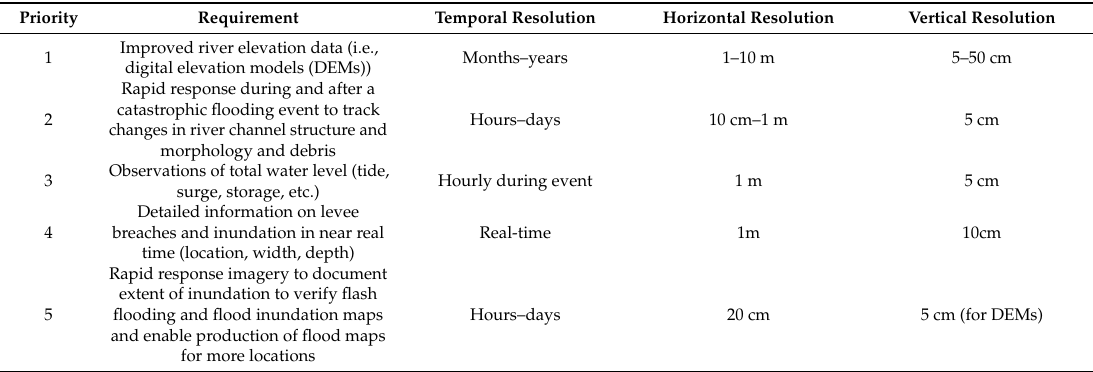
Table 1. National Weather Service (NWS) River Forecast Centers (RFC) requirements based on September 2014